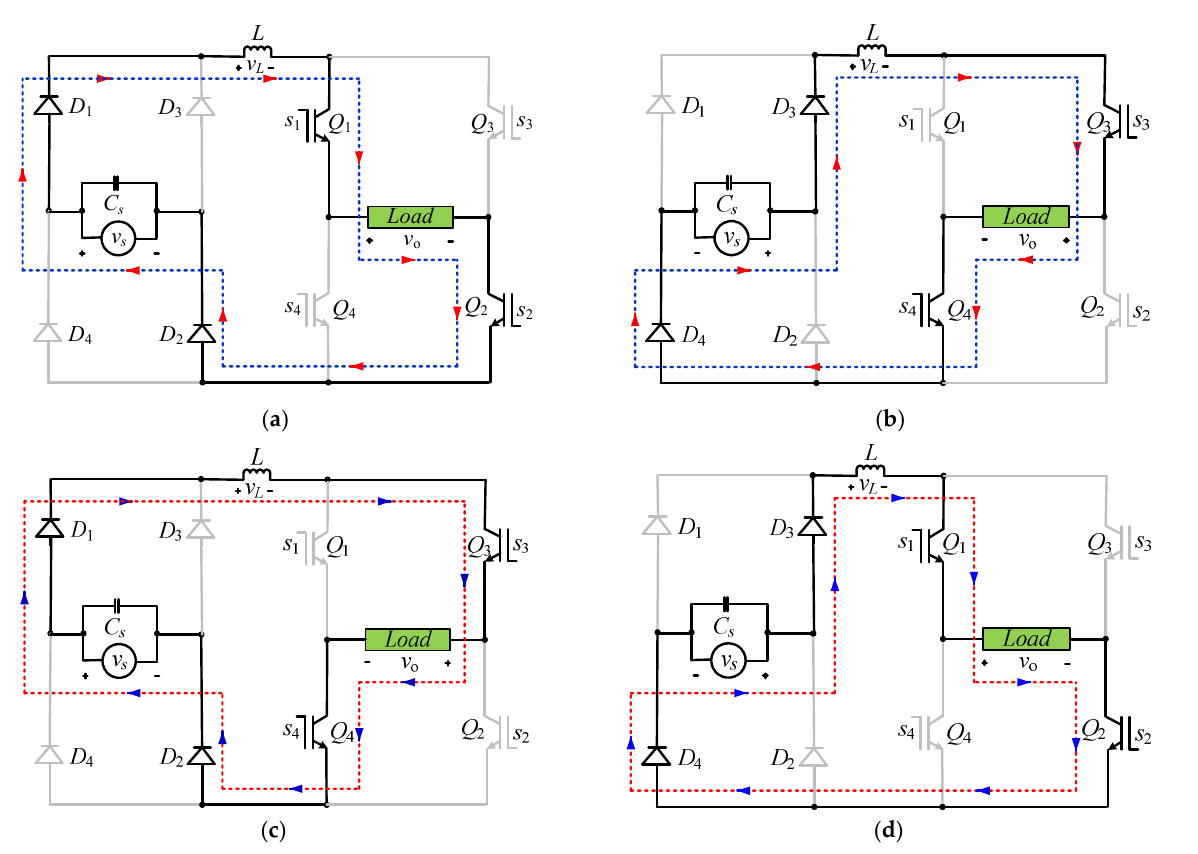
Figure 6. Power transfer loops for operation; ( a , b ) voltage in phase; ( c , d ) voltage out of phase.